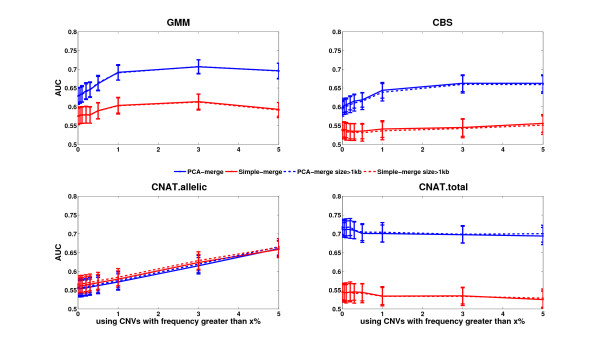
Performance for predicting relatedness based on CNV profiles generated by different methods. Each plot shows the Precision-Recall Area Under the Curve (AUC) (Y axis) for predicting relatedness between individuals as a function of CNV frequency (X axis). CNV detection algorithms are indicated on top and merging procedure by colors. Predictions made with all CNV regions irrespective of their length are shown as straight lines and predictions using only CNV regions with length greater than 1 kb are represented with dashed line (both solid and dash lines overlap each other). Curves were made with the mean from n = 100 permutations, +/- one standard deviation around the mean is shown by the thickness of the square points. The analysis employed 162 pairs of individuals known to be related and 162 pairs of unrelated individuals.